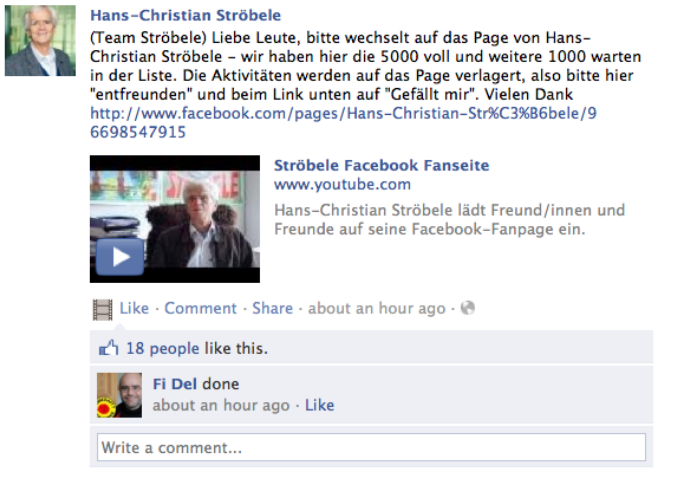
Figure 2: Facebook profile of Hans-Christian Stroebele (Member of German Bundestag) Hans-Christian Stroebele is one of 620 MPs of the German Parliament. He is a member of the Buendnis 90/Die Gruenen party and one of the oldest MPs. In August 2011 his private profile